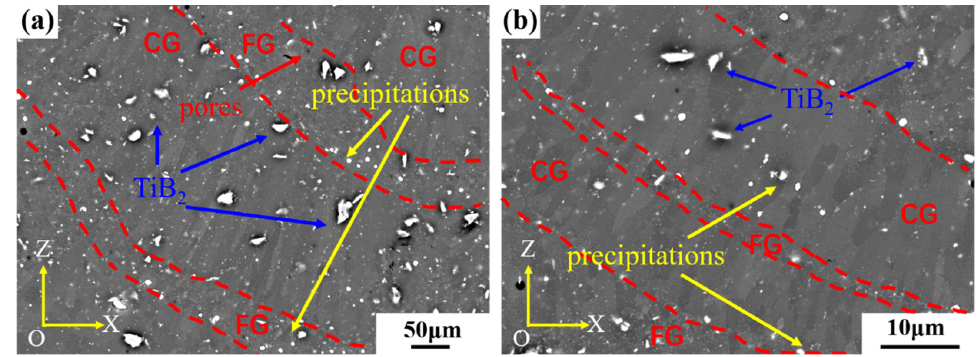
Figure 5. The microstructure of heat-treated TiB2/AlZnMgCu(Sc,Zr) composite samples ( a ) in relatively low magnification and ( b ) in relatively high magnification.